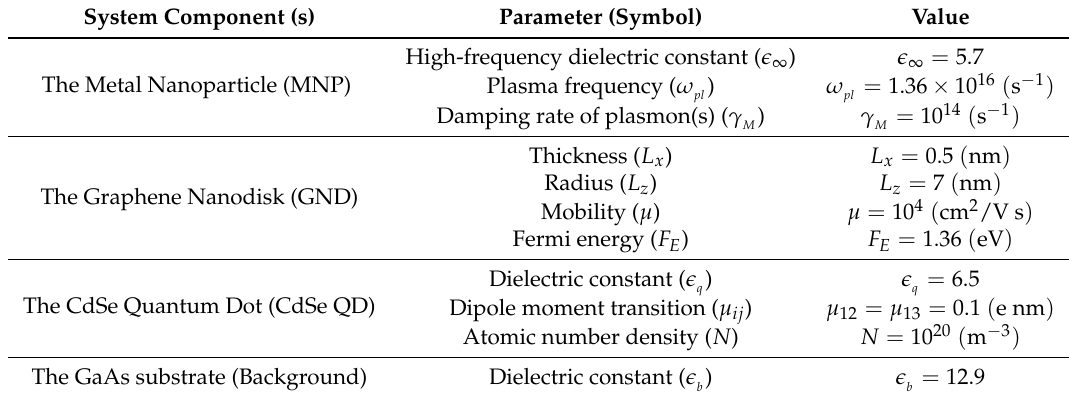
Table 1. The physical parameters used in the numerical